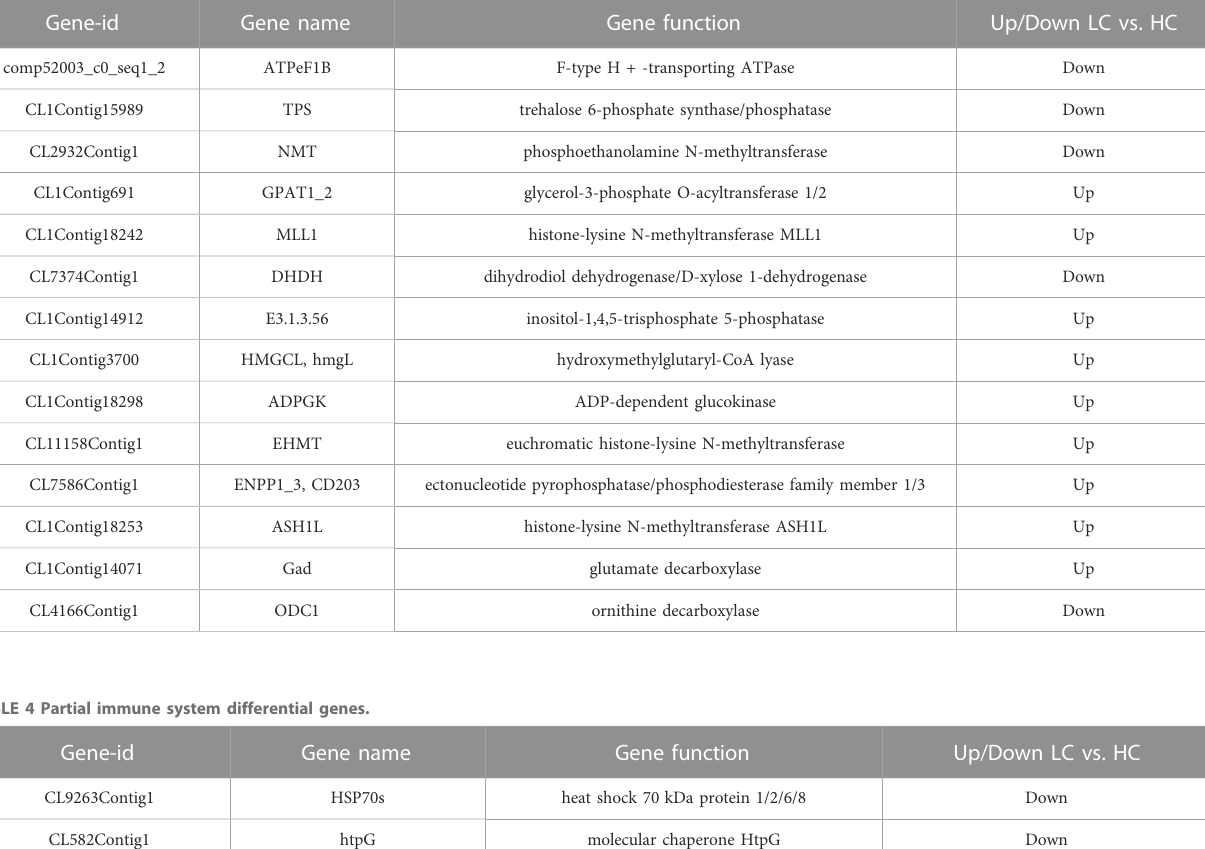
TABLE 3 Partial metabolic differential genes.